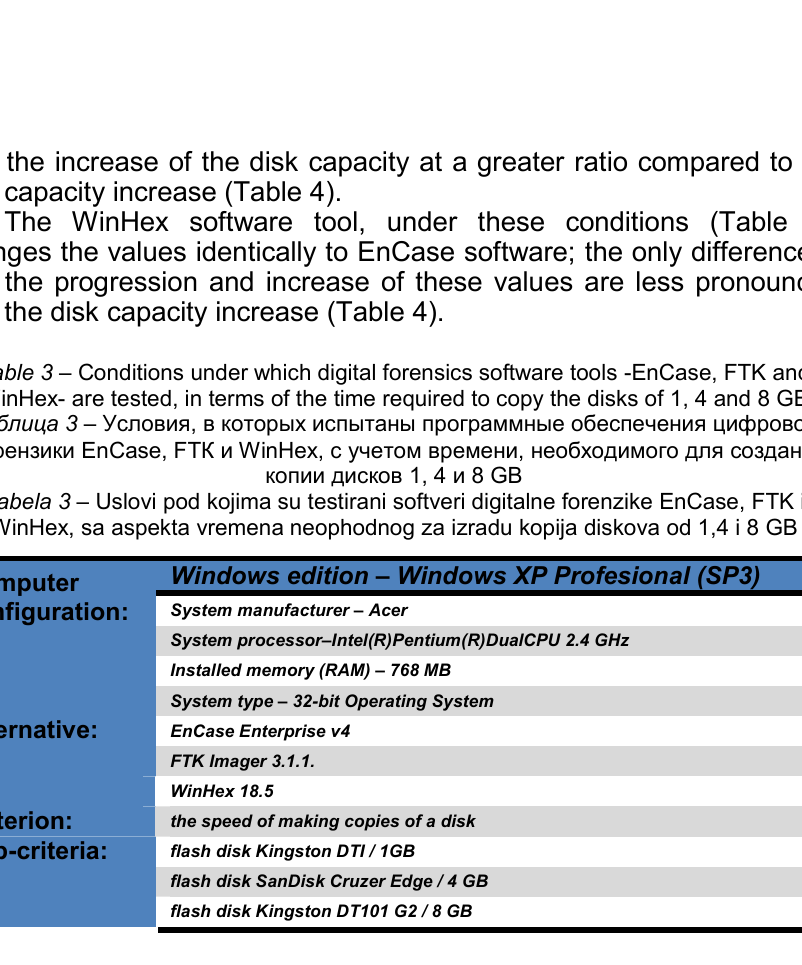
Table 4 – Display of the values obtained by testing digital forensics software tools -EnCase, FTK and WinHex - in terms of the time required to copy the disks of 1, 4 and 8 GB Таблица 4 – Изображение значений , полученных путем тестирования программного обеспечения цифровой форензики EnCase, F ТК и WinHex, с учетом времени , необходимого для создания копии дисков 1, 4 и 8